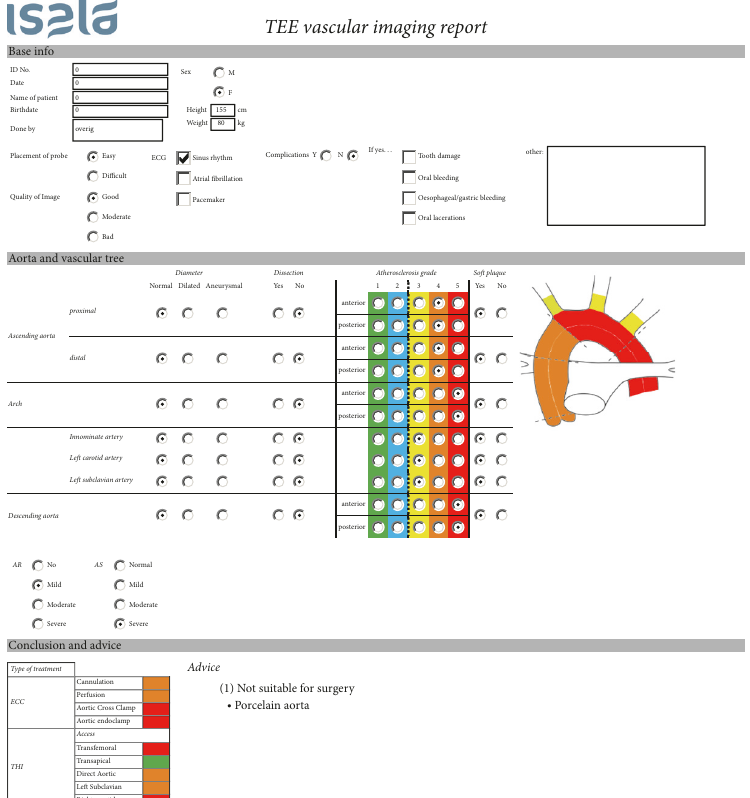
Figure 2: Example of a vascular report in the preoperative screening for possible aortic valve replacement in a patient with severe aortic stenosis. (Modified) TEE showed extensive calcifications of the complete thoracic aorta; it was therefore concluded to perform a transapical aortic valve replacement to minimize manipulation of the